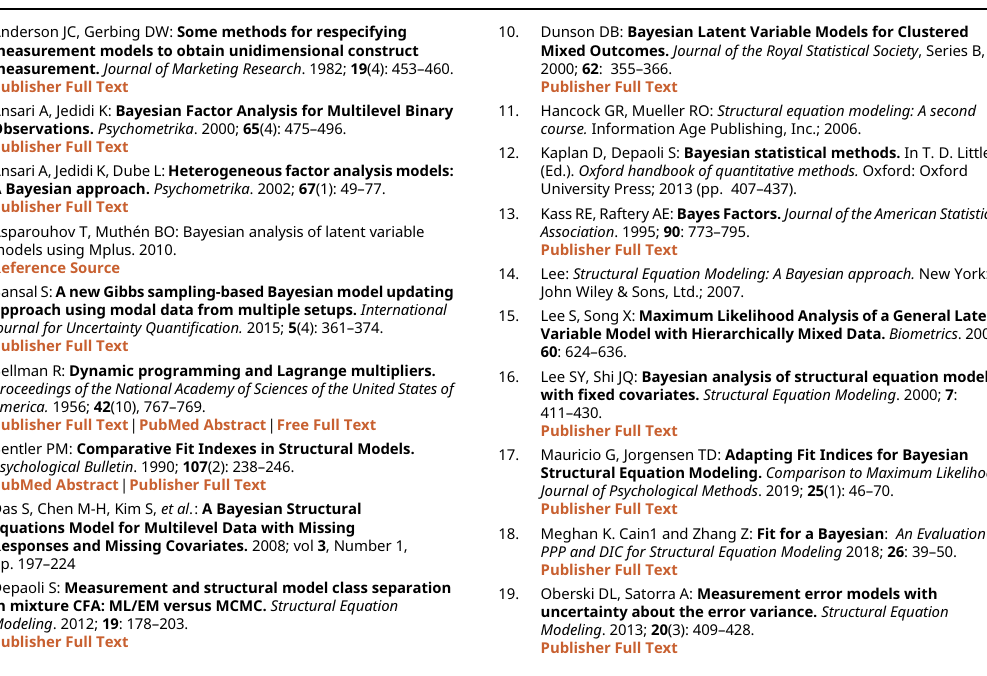
Data are available under the terms of the Creative Commons Zero “ No rights reserved ” data waiver (CC0 1.0 Public domain